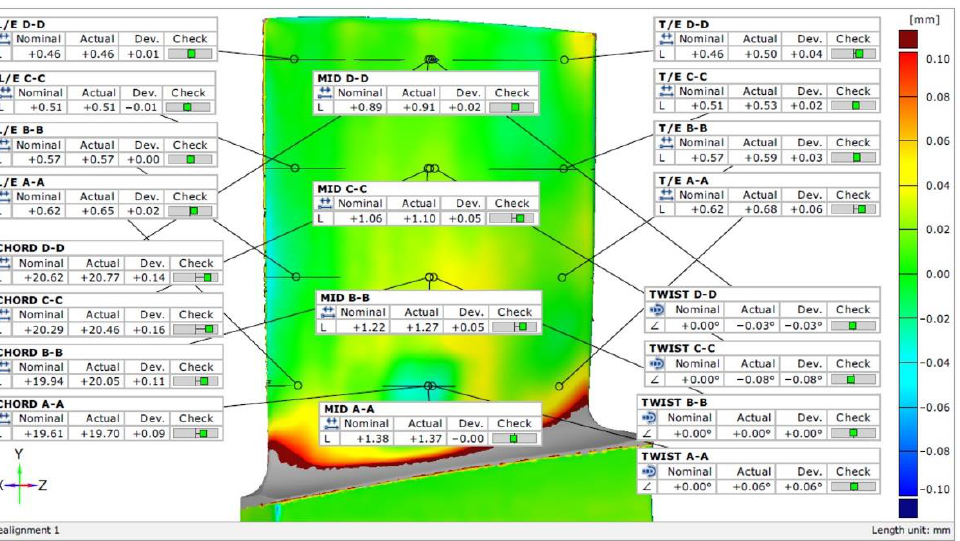
Figure 19. Results of the measurement of the blade in control sections.